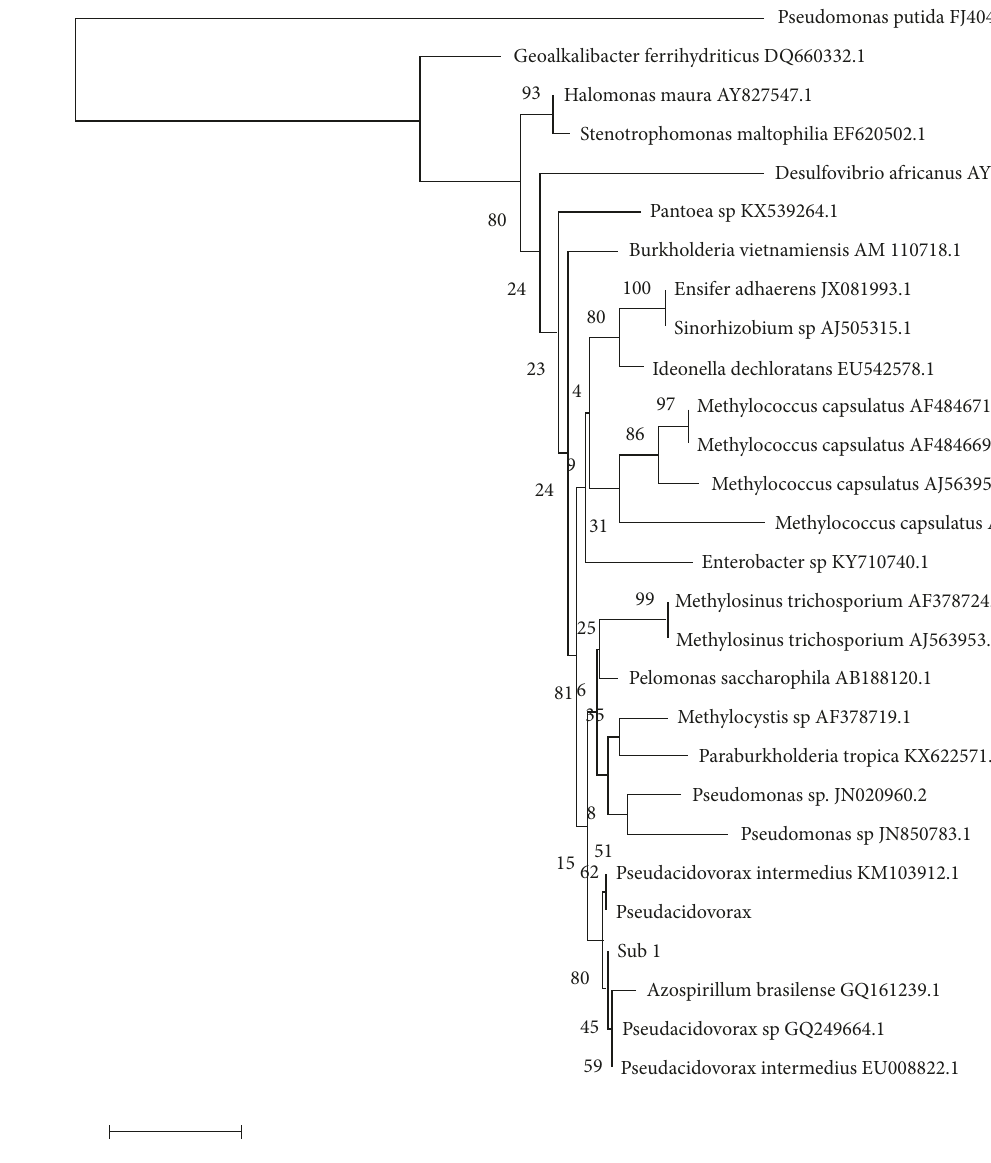
Figure 6: Phylogeneticanalysis using neighborJoining (NJ)trees was constructedusing sequences retrieved from NCBI GenBank (accession numbers are shown in the branch tips along with the sequence name) after ClustalW multiple alignment [14]. The tree was constructed using